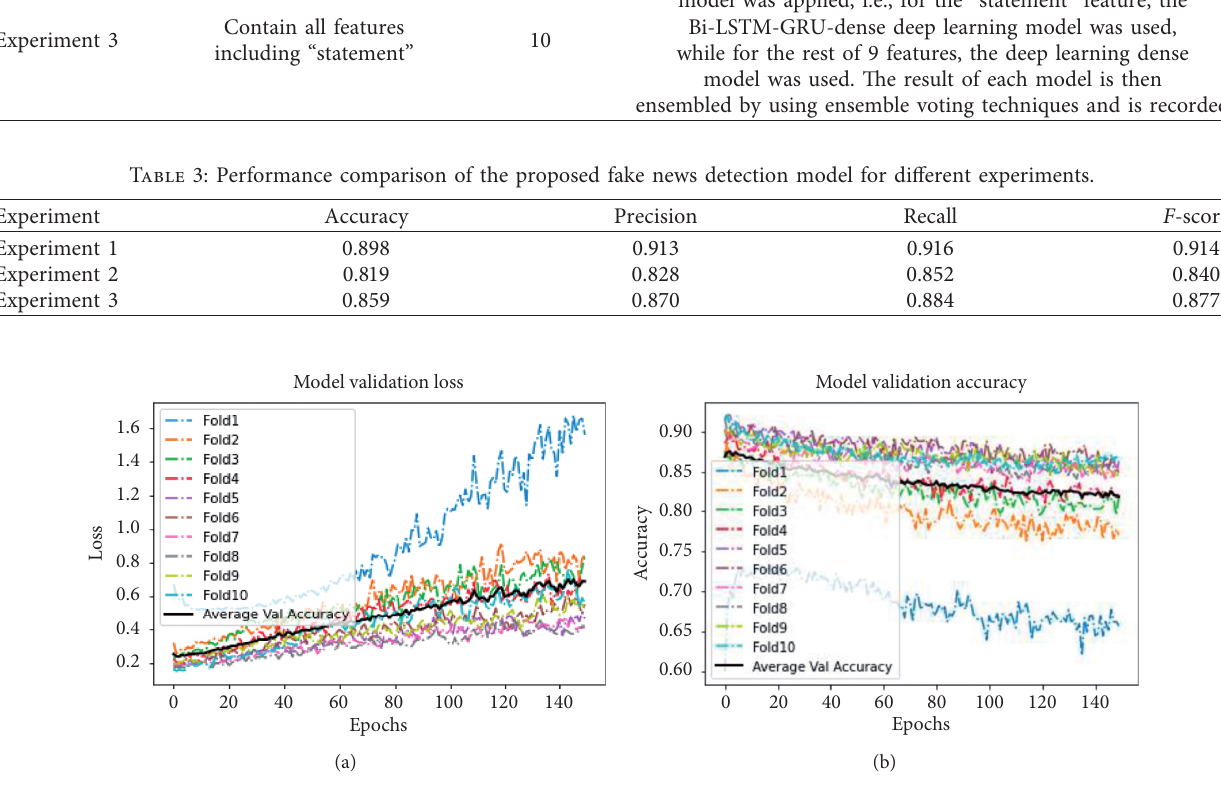
Figure 7: (a) Model validation loss and the number of epochs for Experiment 1. (b) Model validation accuracy and the number of epochs for Experiment